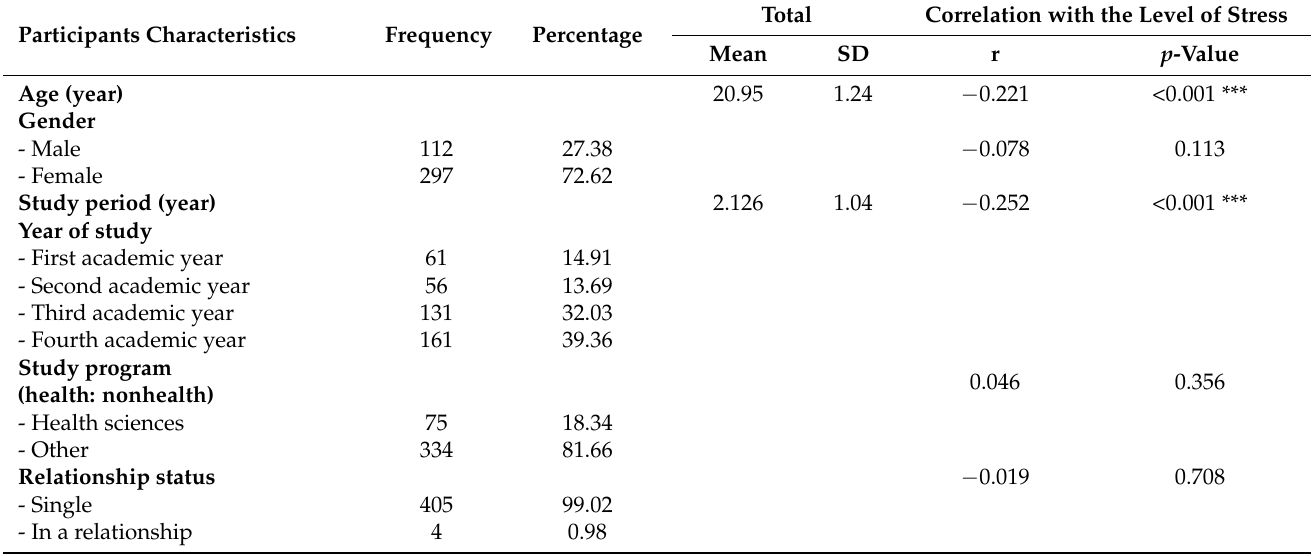
Table 1. Demographic data of participants and correlations between participant characteristics and stress